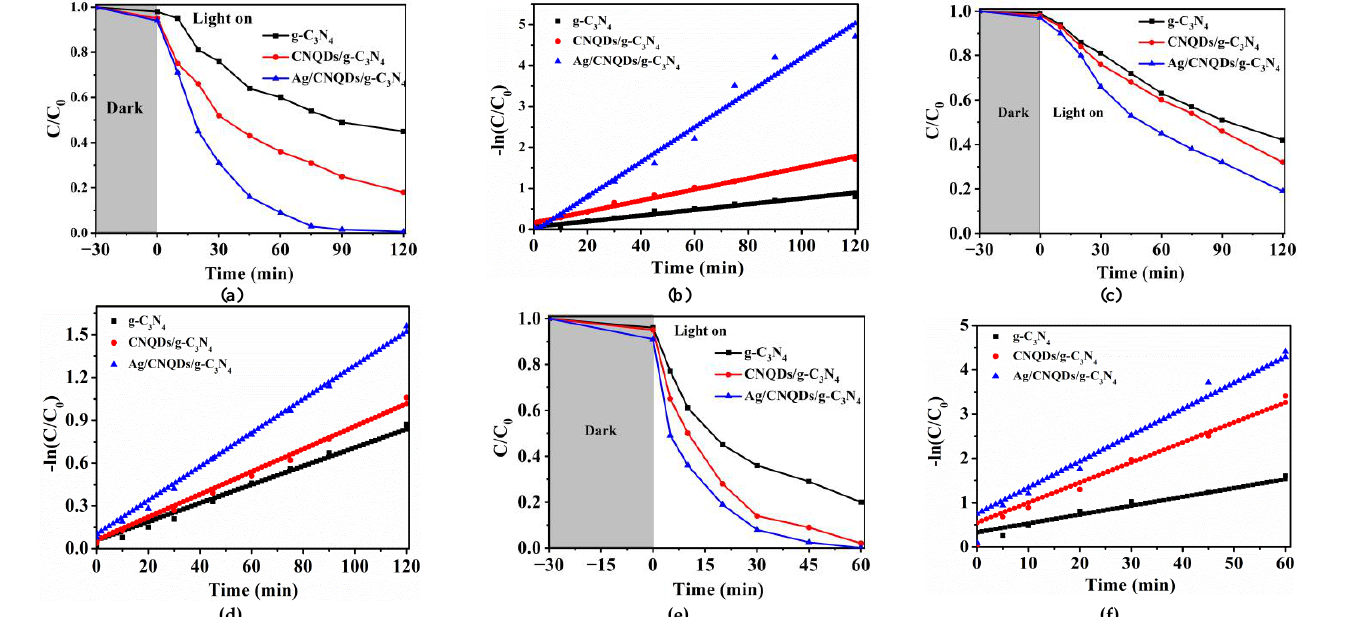
Figure 2. Photocatalytic degradation curves and kinetics of NOR ( a , b ), SMX ( c , d ) and TCH ( e , f ) by Ag/CNQDs/g-C 3 N 4.